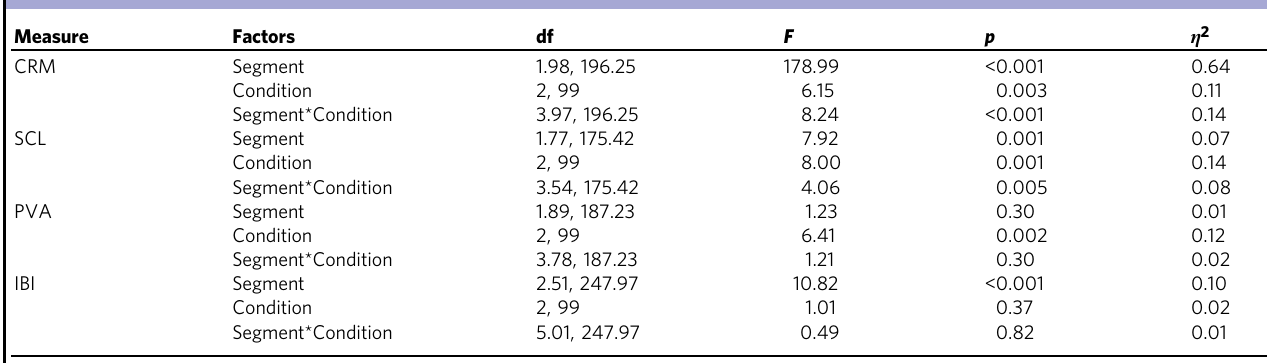
Table 2 ANOVAs for the segment means of the four measures: within-subject factor = fi lm segment; between-subjects factor = condition (AV, video,